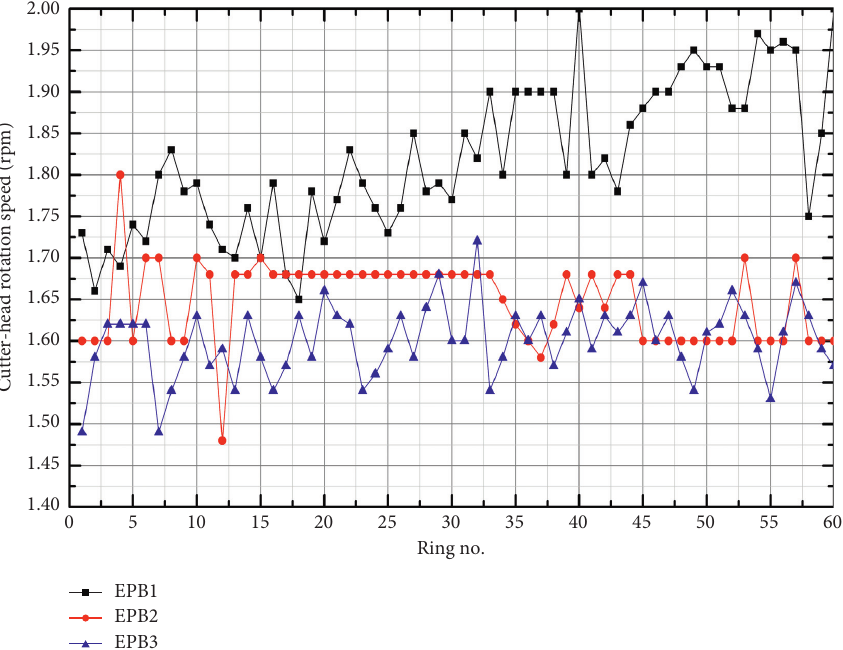
Figure 9: Rotation speeds of the cutter-heads of the three